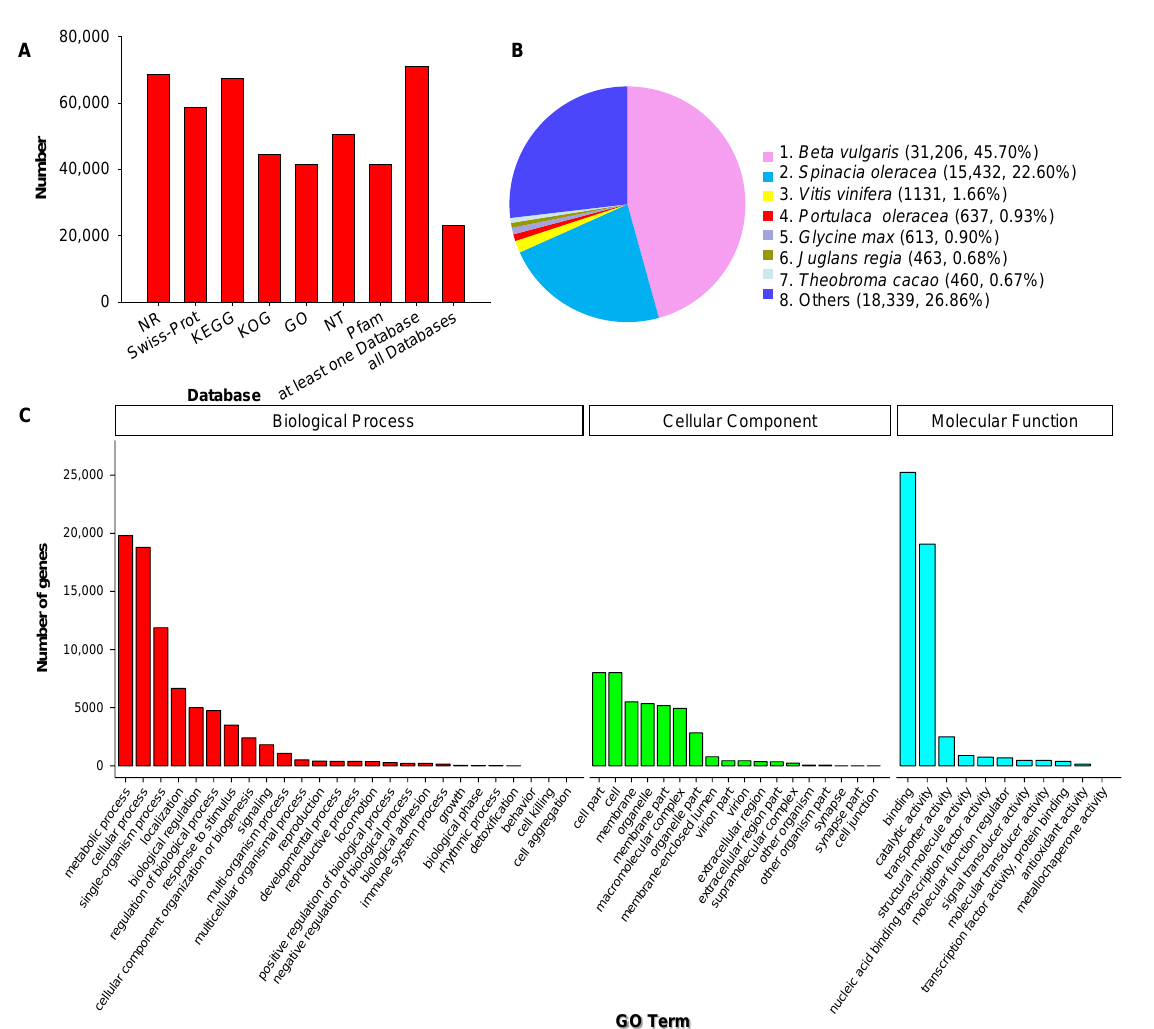
Figure 3. Function annotation of corrected isoforms in seven databases ( A ) (NR, NCBI Nonredundant Protein Database; KEGG, Kyoto Encyclopedia of Genes and Genomes; KOG, cluster of eukaryotic ortholog groups of proteins; GO, Gene Ontology; NT, NCBI nucleotide sequences; Pfam, Protein family), homologous species distribution diagram of transcripts in NCBI nonredundant protein sequences (NR) ( B ), Gene Ontology (GO) classification of unique transcripts ( C ) of purslane ( Portulaca oleracea ).